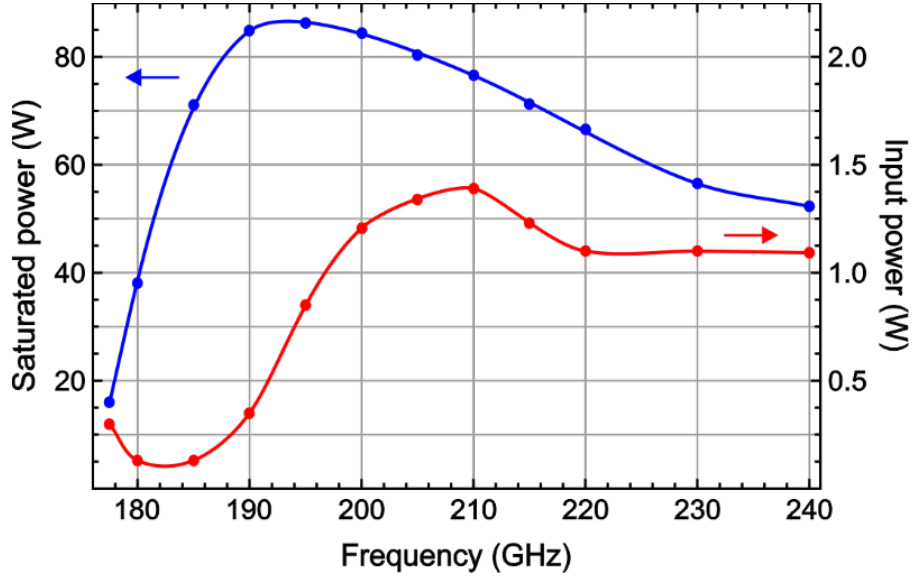
Figure 7. Input and output signal waveforms at 220 GHz frequency and 1 W input power.